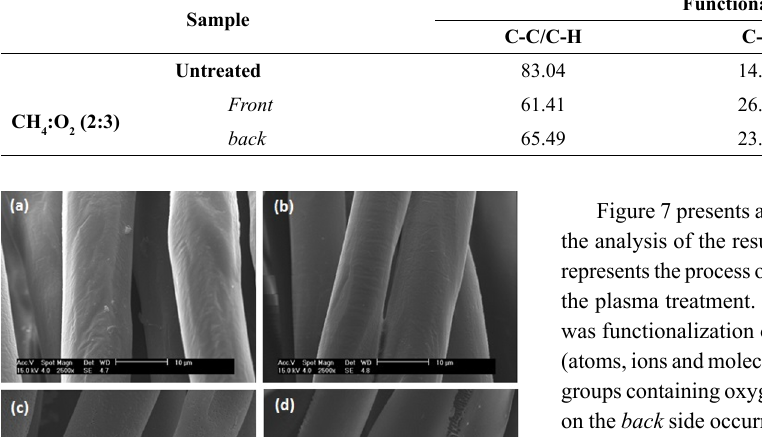
Table 2. Concentration of functional groups identified by the convolution-C1s to sample untreated and treated to plasma with CH